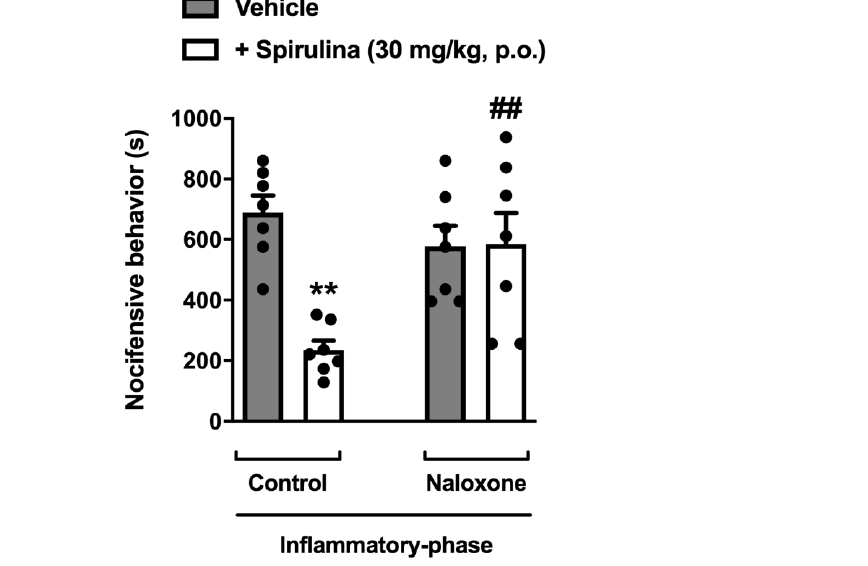
Figure 7. Involvement of opioid receptors in the antinociceptive effect of Spirulina . Spirulina (30 mg/kg, p.o.) or vehicle (0.9%NaCl 10 mL/kg) were administrated in mice previously treated with naloxone (1 mg/kg, i.p., a non-selective opioid receptor antagonist) during formalin-induced nocifensive behavior. Each column represents the mean ± SEM of 7 animals/group, with a black dot showing individual mice. Asterisks denote the levels of significance compared to the control group. ** p < 0.001, ## p < 0.001 using one-way ANOVA.